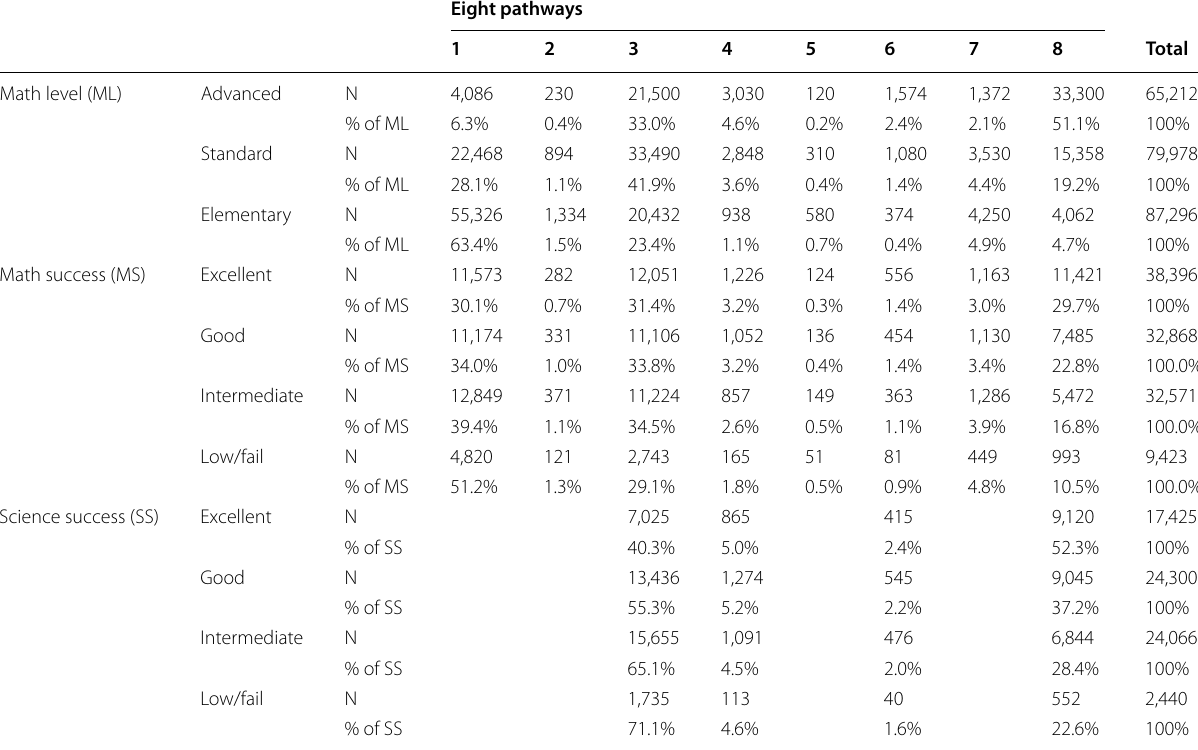
Table 6 The distribution of educational characteristics according to the eight